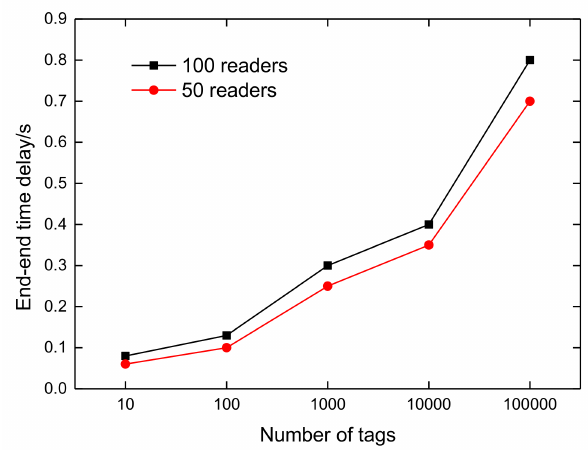
Figure 3. Scalability evaluation.